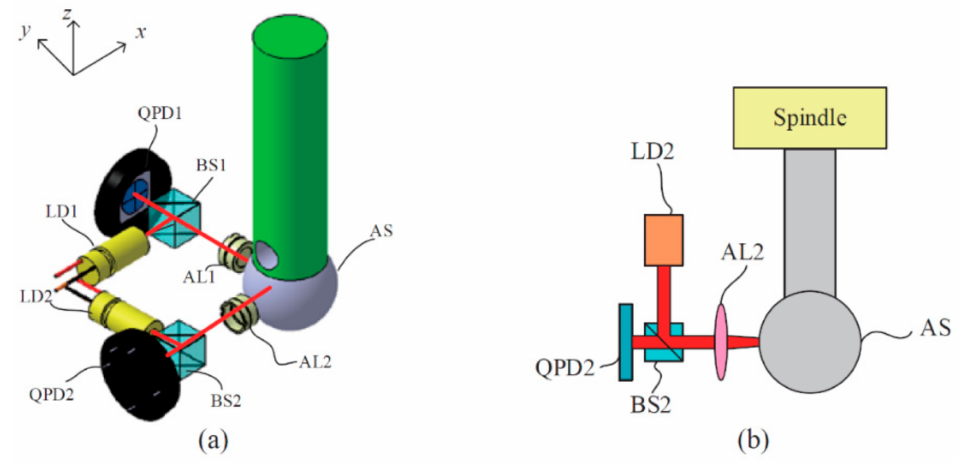
Figure 37. ( a ) Layout of the spindle error motion measurement device and ( b ) optical path of a sensor setup [33].